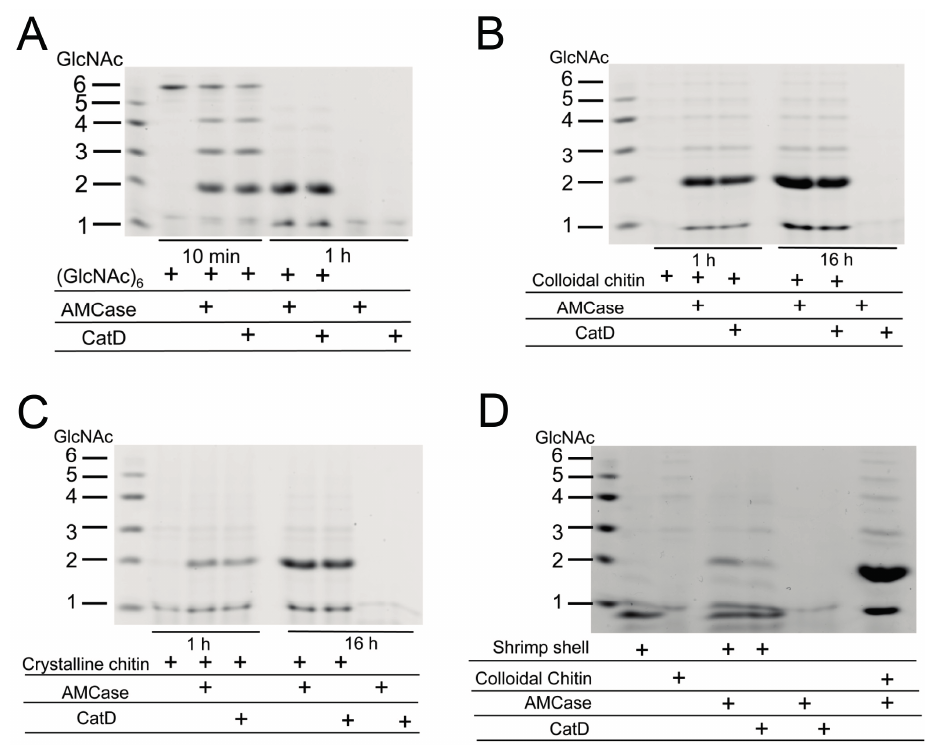
Figure 5. Degradation products of GlcNAc hexamer, colloidal and crystalline chitin and shrimp shell by CatD. GlcNAc hexamer ( A ); colloidal ( B ) and crystalline ( C ) chitin and shrimp shell ( D ) were used as a substrate to determine the chitinase activity of E. coli -expressed proteins in 0.1 M Gly-HCl (pH 2.0). Reactions were conducted for 10 min, 1 or 16 h at 37 °C. Shrimp shell ( D ) was digested for 16 h. The